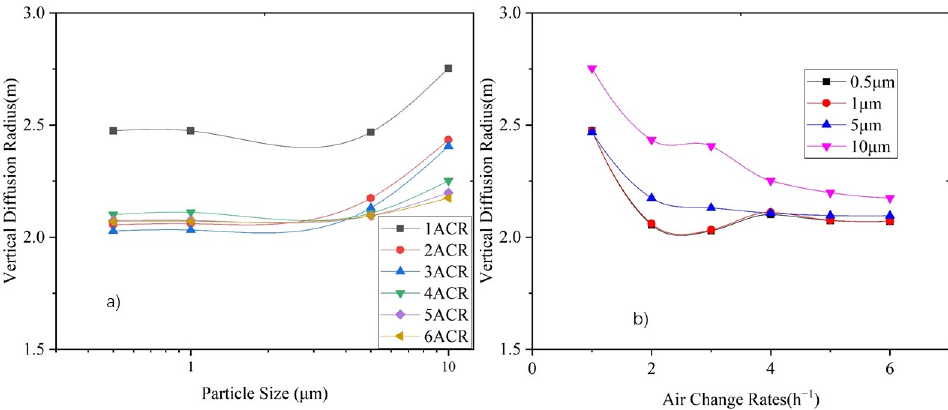
Figure 12. Variation in vertical diffusion radius height under ACR of 1–6 for each particle size. ( a ) Relationship between diffusion radius and particle size, and ( b ) relationship between diffusion radius and air changes rate.